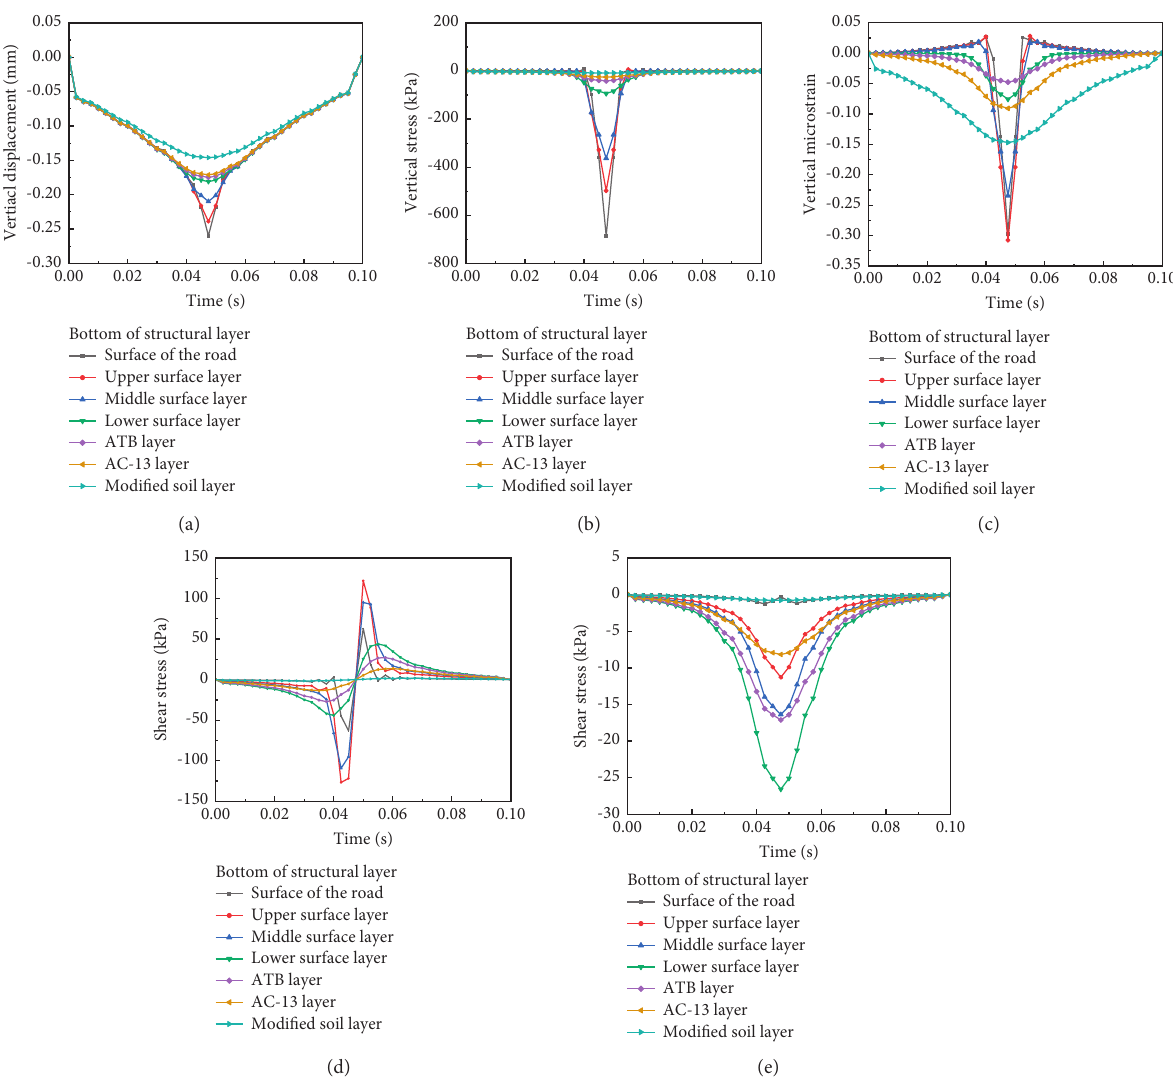
Figure 5: Time history curve of (a) vertical displacement, (b) vertical stress, (c) vertical micro strain, (d) longitudinal shear stress, and (e) transverse shear stress at each layer of structure